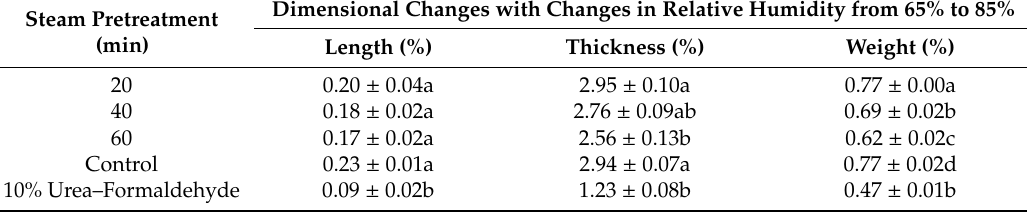
Table 2. Dimensional changes with changes in relative humidity from 65% to 85% of particleboards made without synthetic adhesives and with steam-pretreated particles.